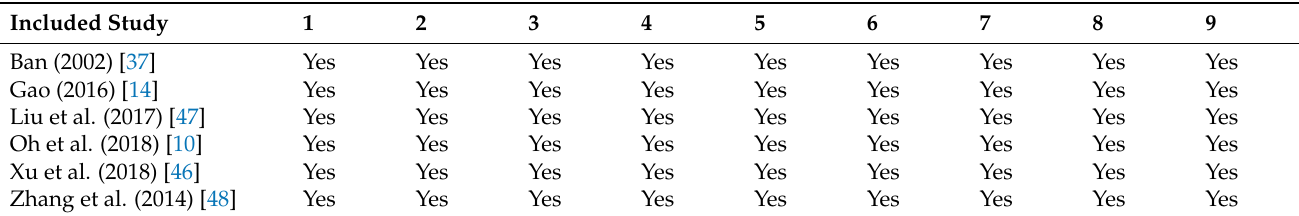
Table 3. Risk of bias of the included studies (quasi-experimental studies).